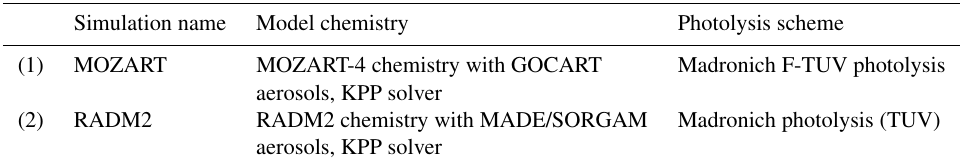
Table 2. Description of WRF-Chem simulations performed for this